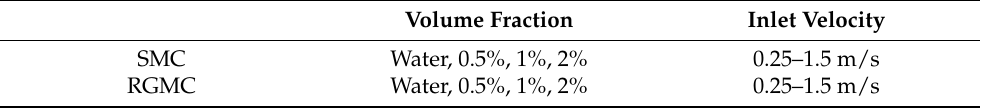
Table 3. Range of variables in the study